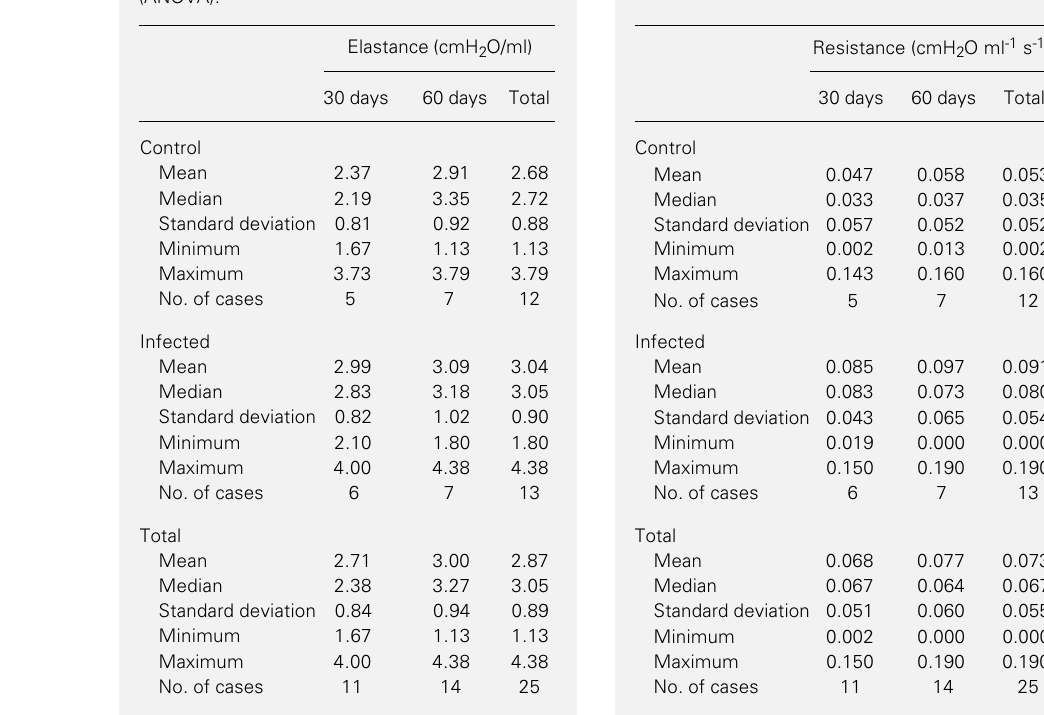
Table 3 - Paracoccidioidomycosis (PBM) infection has no effect on pulmonary resistance. Neither PBM infection (P = 0.098), time of infec- tion (P = 0.609) nor interaction infection vs time (P = 0.993) were statistically significant